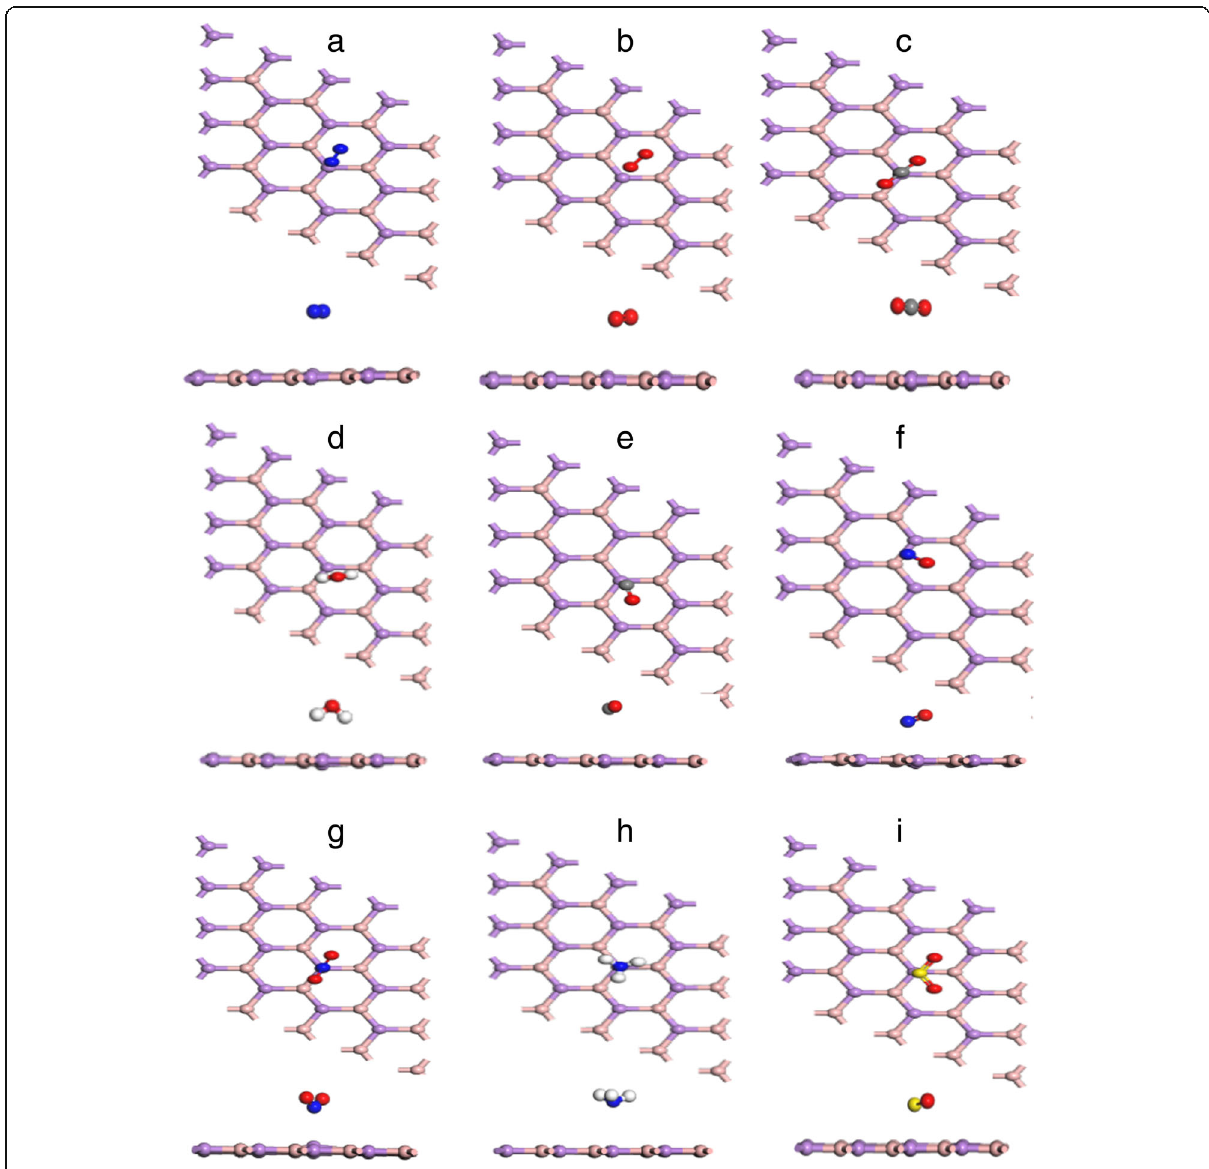
Fig. 2 The most energetically favorable adsorption configurations of the gas molecules: N 2 ( a ), O 2 ( b ), CO 2 ( c ), H 2 O ( d ), CO ( e ), NO ( f ), NO 2 ( g ), NH 3 ( h ), and SO 2 ( i ) on monolayer